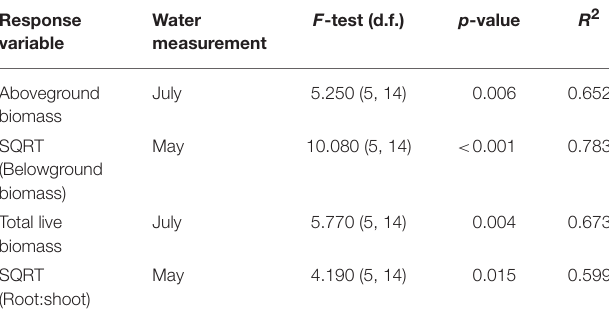
TABLE 2 | General linear model fit tests for 2016 and 2017 biomass response variables (g m − 2 aboveground, belowground, total biomass, root: shoot), soil nutrient concentration (total carbon, total nitrogen and plant available phosphorus, potassium, magnesium, and calcium), tissue carbon and macronutrient concentrations (% dry weight of carbon, nitrogen, phosphorus, potassium, magnesium, and calcium), and carbon and macronutrient standing stock (g m − 2 of carbon, nitrogen, phosphorus, potassium, magnesium, and calcium).